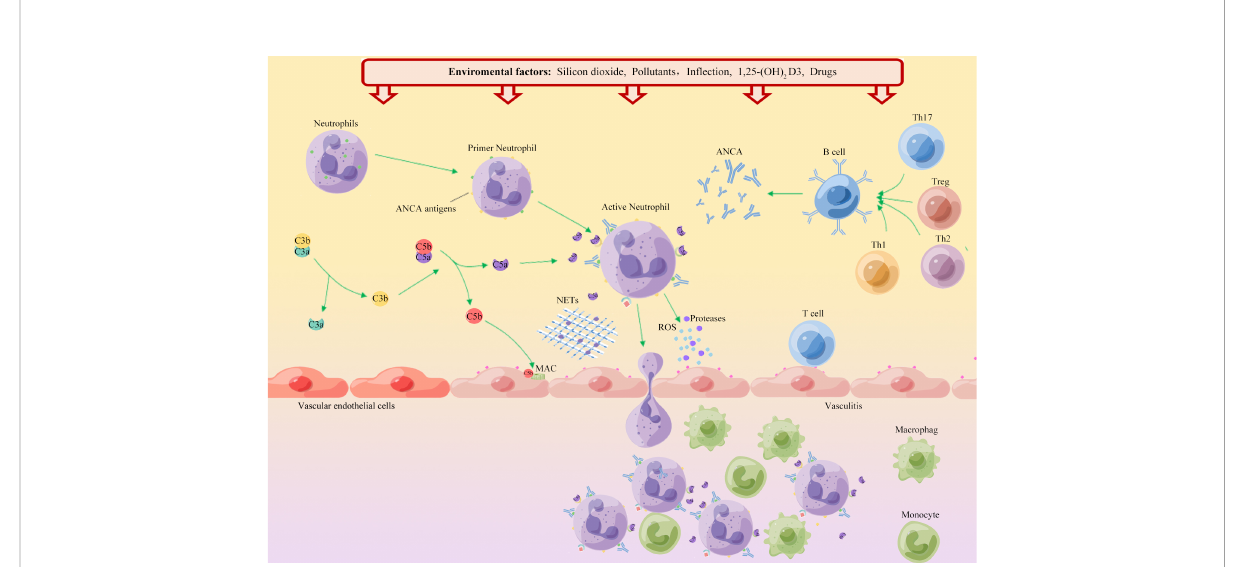
FIGURE 1 Schematic diagram of the environmental factors in the onset of AAV. ANCA autoantigens (PR3 and MPO) are usually hidden in the primitive granules of neutrophils. Environmental factors such as silica, air pollution, and infection, lead to neutrophil initiation and PR3 and MPO movement to the cell surface. Binding of ANCA to these autoantigens leads to activation of neutrophils, which adhere to the vascular endothelium. Neutrophil degranulation leads to the release of reactive oxygen species (ROS), proteases and neutrophil extracellular traps (NETs), which in turn destroy endothelial cells. Chemokines and tissue deposition of PR3 and MPO lead to increased tissue damage by recruitment of autoreactive T cells and monocytes. Additionally, ANCA binds to cell surface autoantigens, leading to neutrophil activation and release of factors that activate the complement replacement pathway. The production of the allergenic toxin C5a further attracts neutrophils and enhances neutrophil initiation and activation upon binding to cell surface C5a receptors, thereby promoting vascular in fl